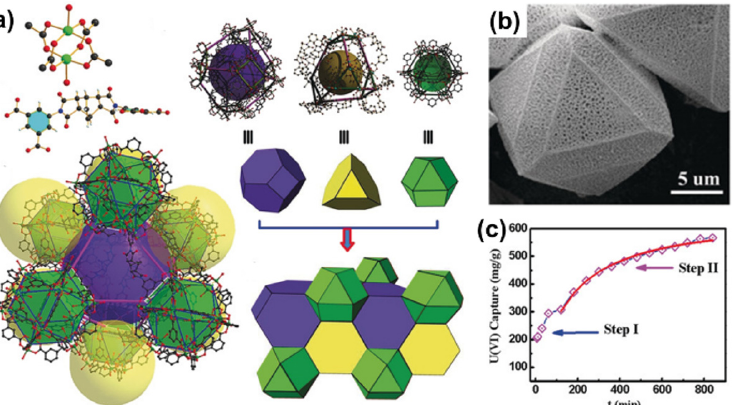
Figure 1. Structure of USC-CP-1 (the purple, yellow and green units represent three different micropores), ( a ) molecule used for synthesis of USC-CP-1 , ( b ) SEM of USC-CP-1 , ( c ) equilibrium data with continuous line fit based on the Langmuir model of uranyl adsorption on USC-CP-1 at pH 5.5 [31], Copyright 2019 John Wiley and Sons.